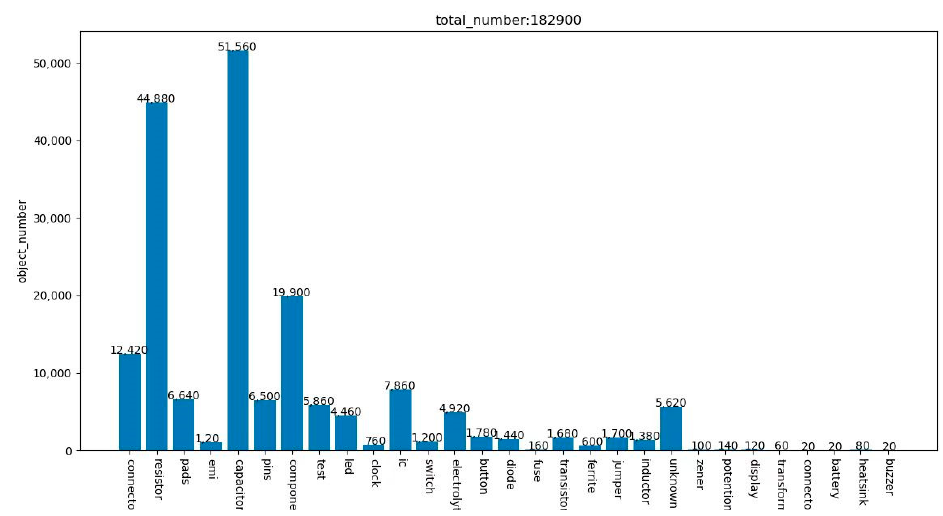
Figure 8. Number and category of electronic components after data augmentation.